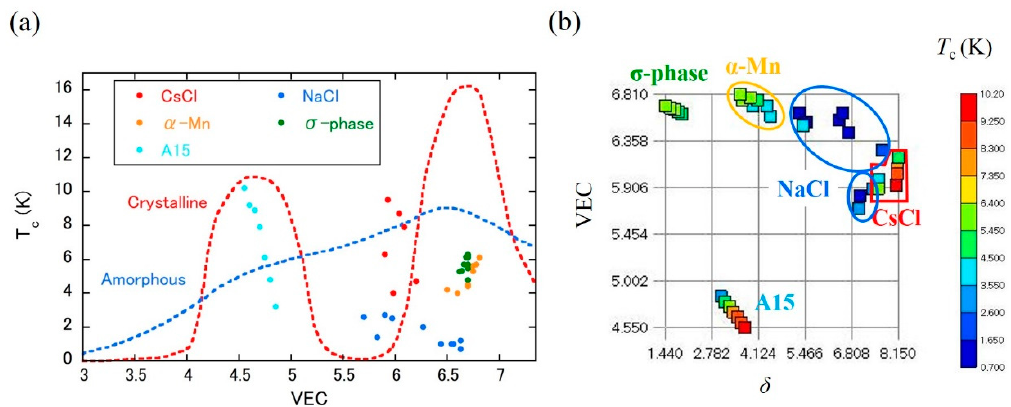
Figure 9. ( a ) VEC dependence of T c for multisite HEA superconductors. The same dependences are also shown for crystalline and amorphous superconductors by the dotted lines. Data for the dotted lines are from [16]. ( b ) δ and VEC dependence of T c for multisite HEA superconductors.